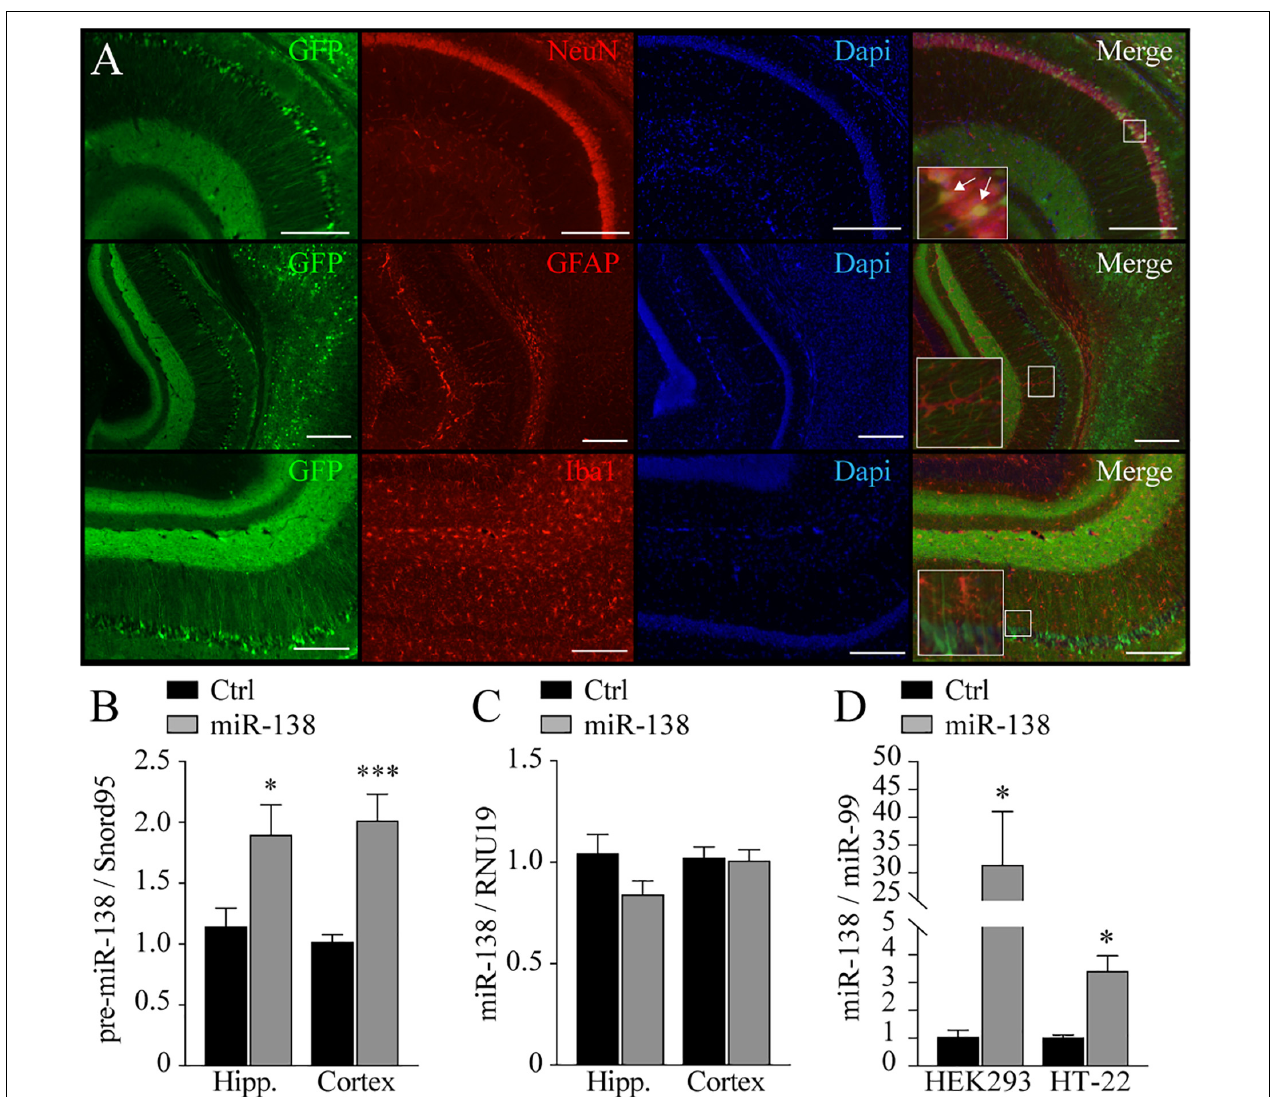
FIGURE 1 | Expression and localization of AAV2 in the brain. (A) Characterization of AAV2/DJ8-CAG-eGFP in wild-type mice at 2 months of age: eGFP labeling in green; Neuronal marker: NeuN or Glial marker: GFAP or Iba1, in red. Nuclei marker: DAPI, in blue. Merge of green, red, and blue fluorescence. Immunofluorescence performed in half-brain of 2 months-old mice, 2 months after injections ( n = 3). Note that most, if not all, co-stainings with eGFP are with the neuronal NeuN marker. Scale: 250 nm. (B) Expression of pre-miR-138 in hippocampus (Hipp.) and frontal cortex (Cortex) of mice at 4 months of age, injected with AAV2/DJ8-CAG-eGFP-MIR-138-2 (miR-138; n = 14) or AAV2/DJ8-CAG-eGFP (Ctrl; n = 16). (C) Expression of mature miR-138-5p in hippocampus (Hipp.) and frontal cortex (Cortex) of mice at 4 months of age injected with AAV2/DJ8-CAG-eGFP-MIR-138-2 (miR-138; n = 14) or AAV2/DJ8-CAG-eGFP (Ctrl; n =